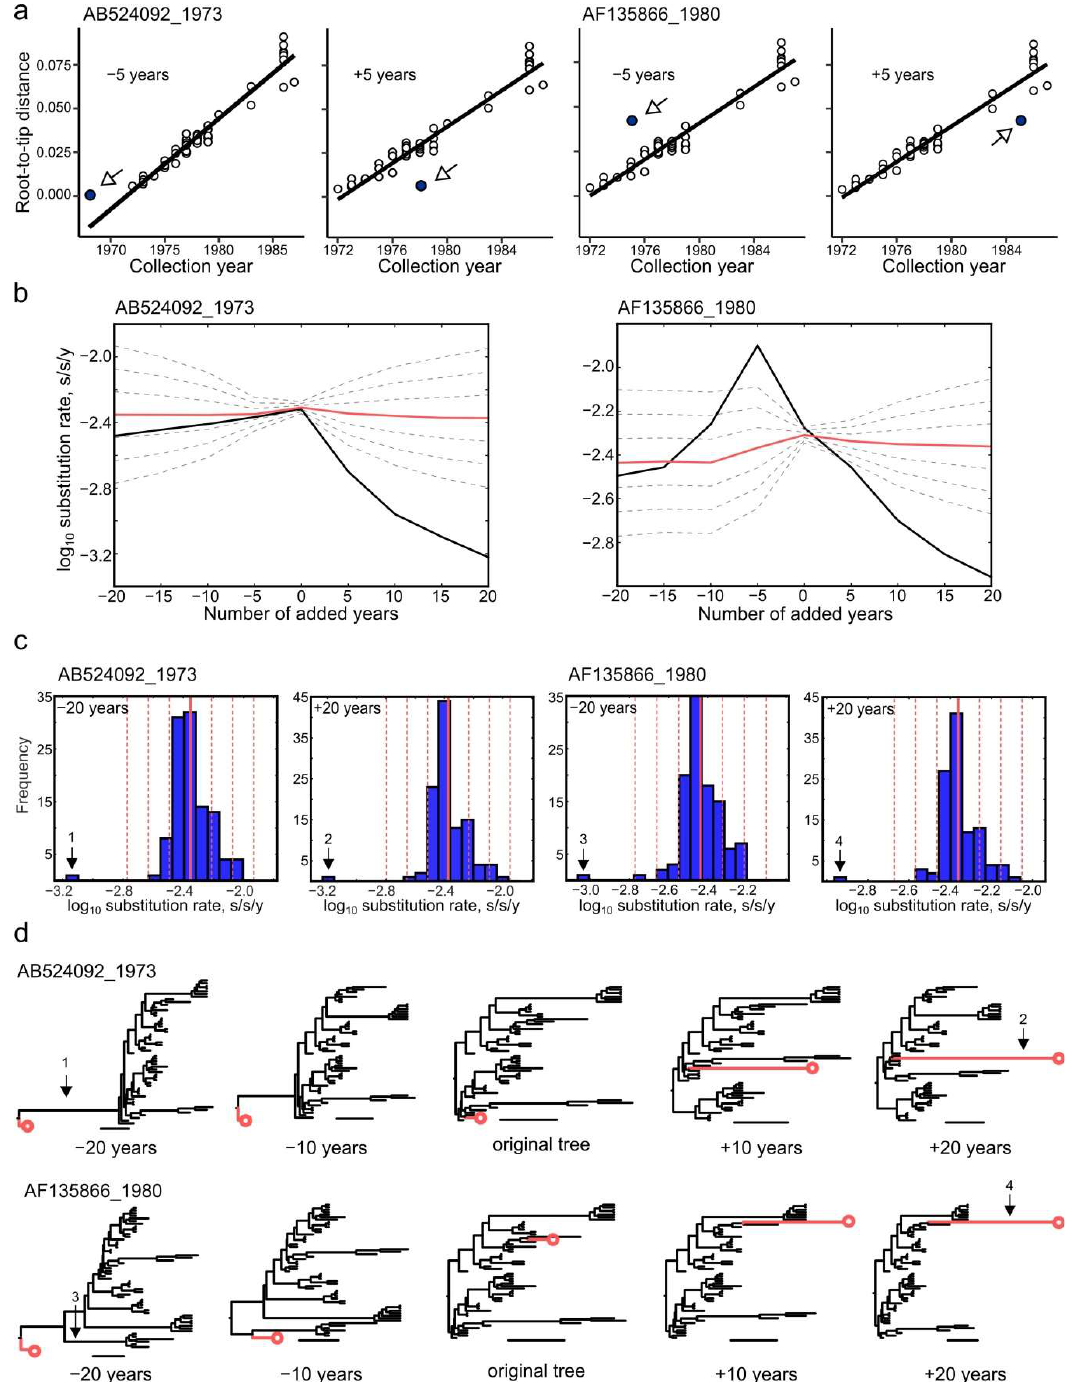
Figure 7. ( a ) Analysis of the EV-A71 genotype B1 temporal structure using TempEst software after adding and subtracting 5 years from the collection dates of either AB524092 or AF135866 isolates. Blue dots correspond to the isolates with an altered collection year. ( b ) The influence of changing the collection date of an isolate on the branch substitution rates inferred in Bayesian phylogenetic analysis for EV-A71 genotype B1 sequences AB524092 and AF135866. The mean branch rate is plotted with a bold red line; the terminal branch rate to the altered sequence is plotted with a black line. Dashed gray lines indicate mean ± 1SD, 2SD and 3SD of the branch rates in the inferred trees. ( c ) The frequency distribution of decimal logarithms of substitution rates in genotype B1 trees that included sequences AB524092 and AF135866 after adding or subtracting 20 years from their collection dates. Solid red